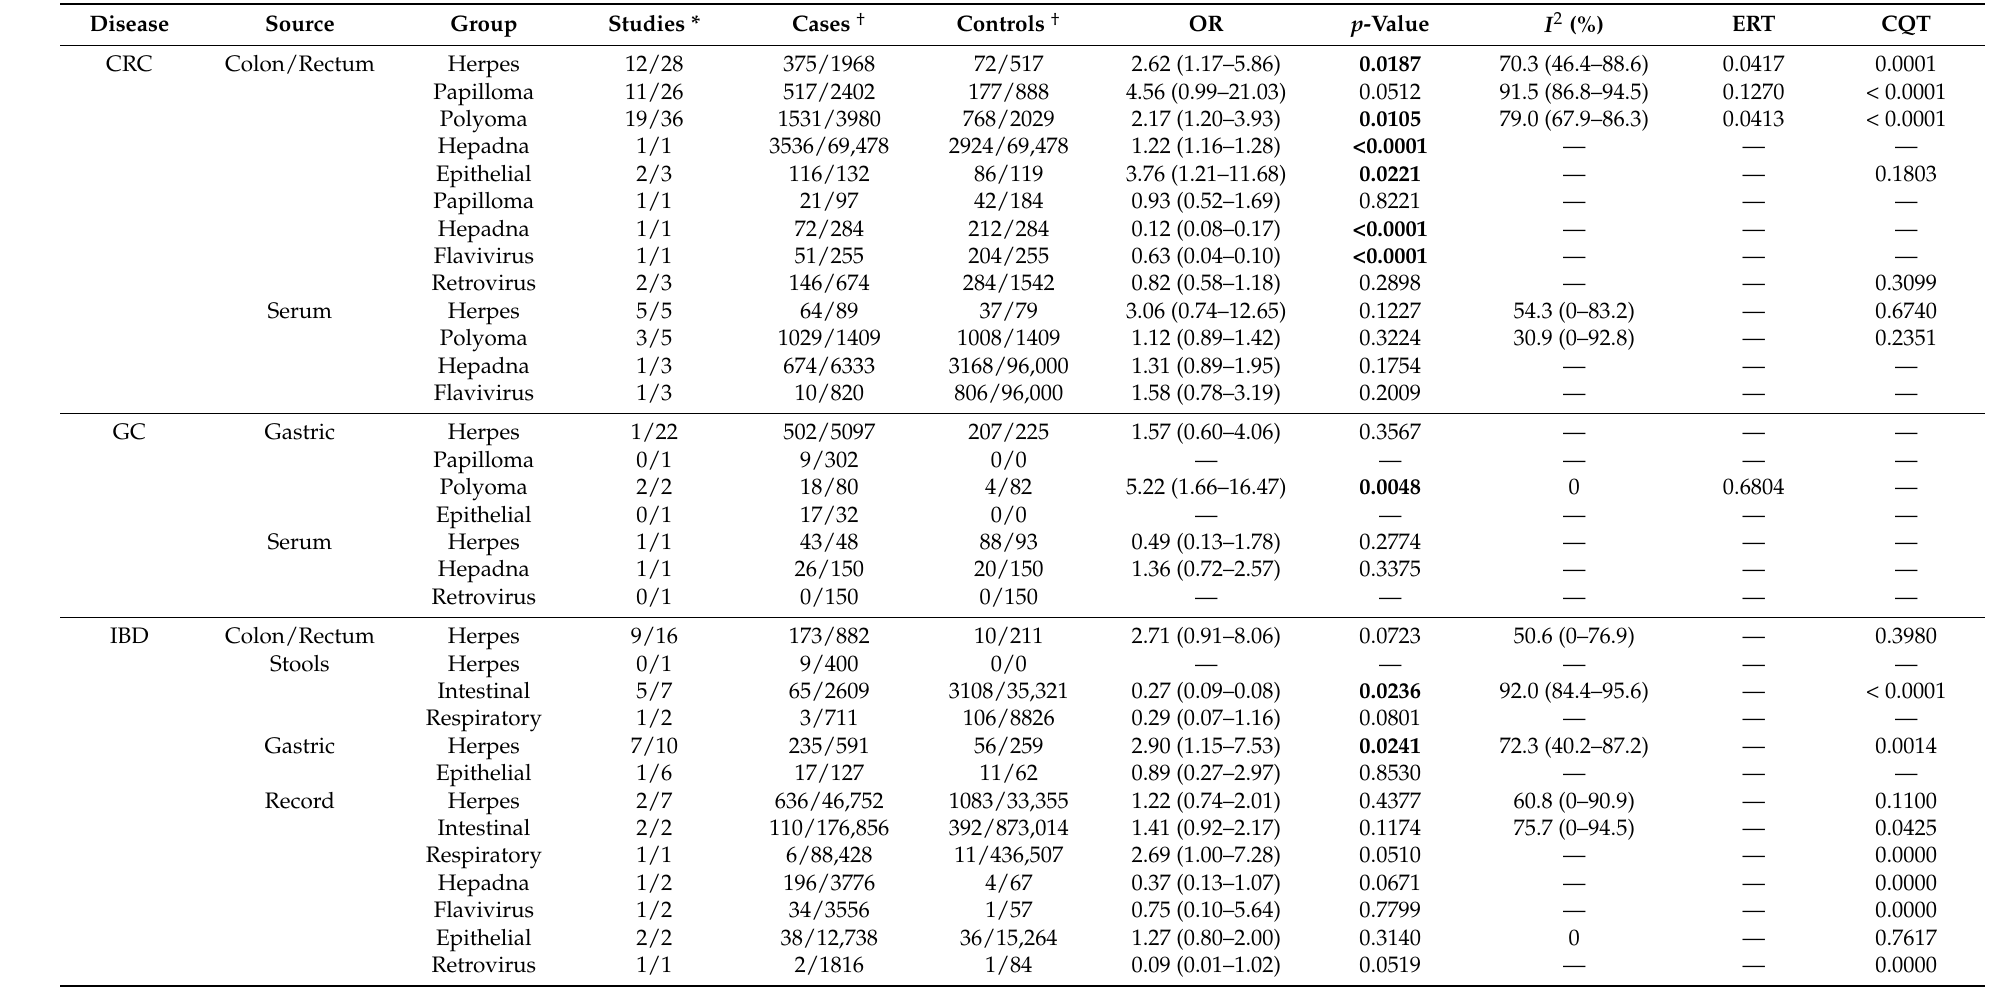
Table 1. Mixed-affect model for the risk of CRC, GC, and IBD predicted by the studies selected for the present meta-analysis. The studies are stratified by specimen type (Source) and virus type (Group). The ORs are reported with their 95% confidence interval and p -value. I 2 = Higgins index; ERT = Egger’s regression test; CQT = Cochran’s Q